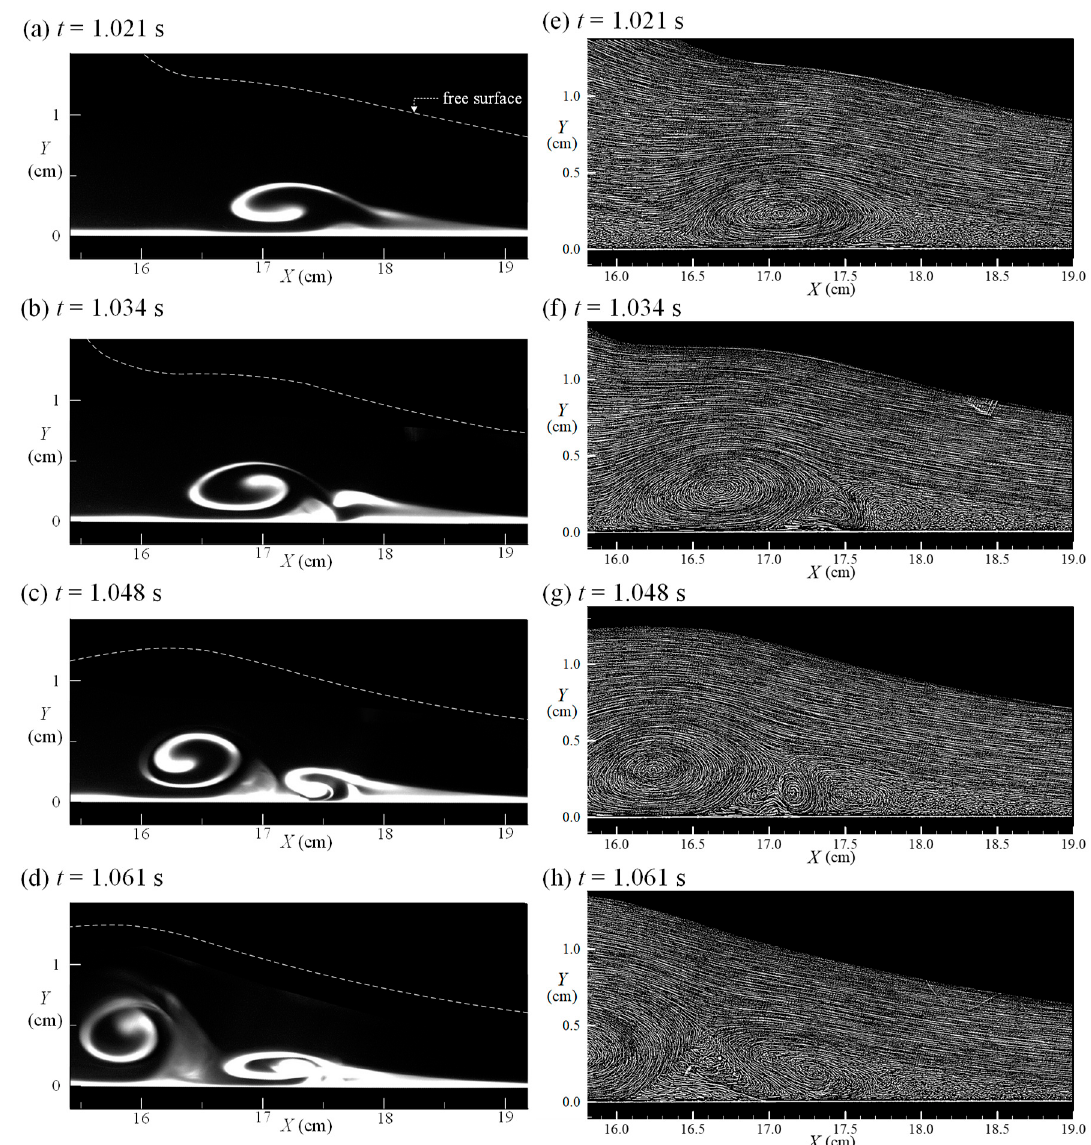
Figure 17. The streaklined and pathlined images (displayed in the left and right panels, respectively) showing evolution of the primary vortex at t = ( a , e ) 1.021 s; ( b , f ) 1.034 s; ( c , g ) 1.048 s; and ( d , h ) 1.061 s.